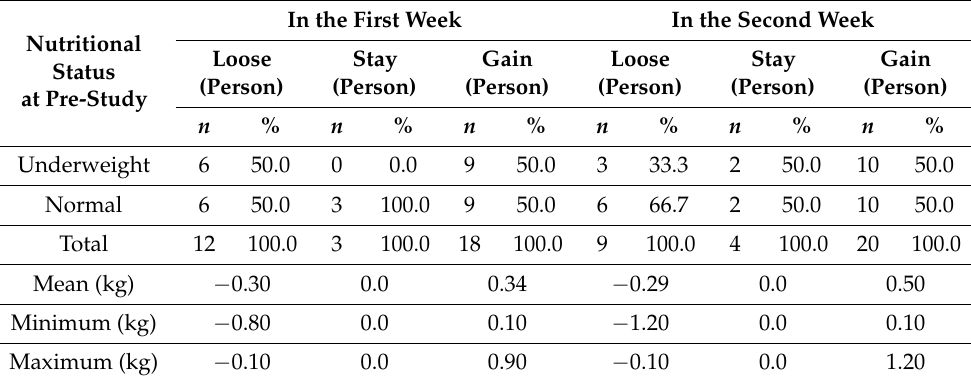
Table 4. Change of weight at pre-post